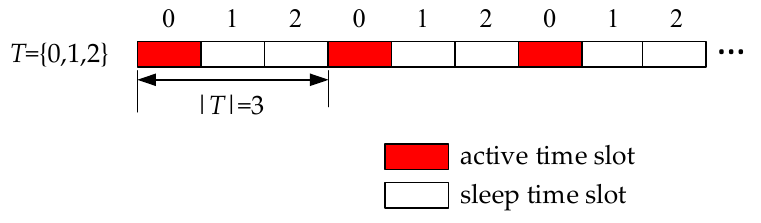
Figure 2. The example of active/sleep time slot.